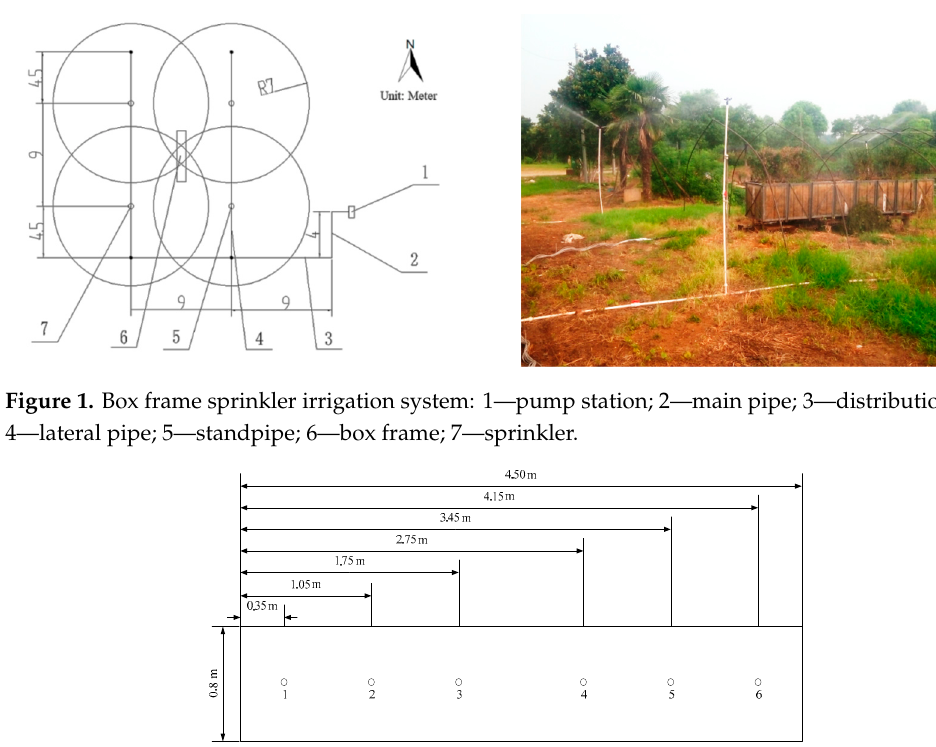
Figure 2. Tea plant distribution in the box frame. Table 1. Technical parameters of the